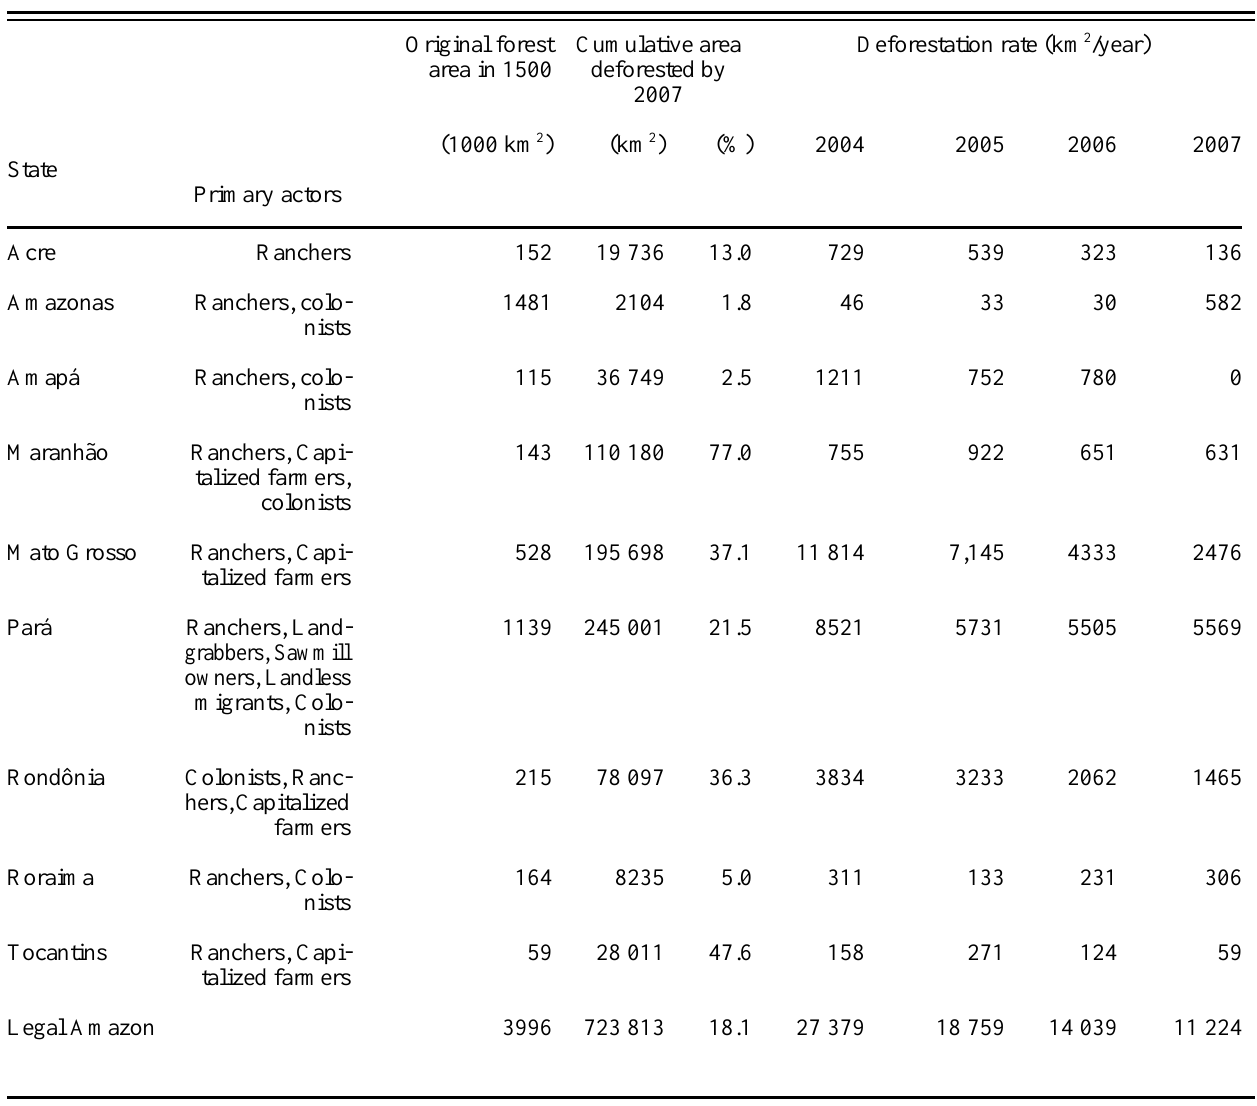
Original forest area in 1500